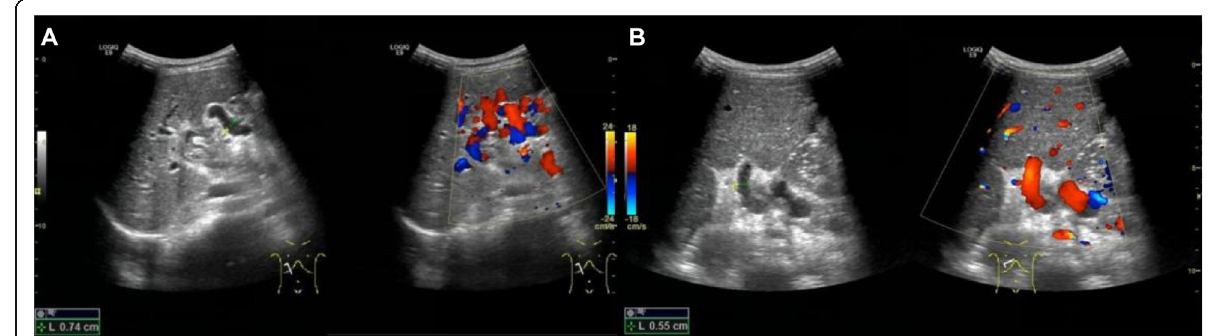
Fig. 2 Rich blood flow signals and good patency in the bypass vessels on the color Doppler ultrasonography at 7 days after Rex-bypass operation for CTPV. a 7-year-old boy. b 6-year-old